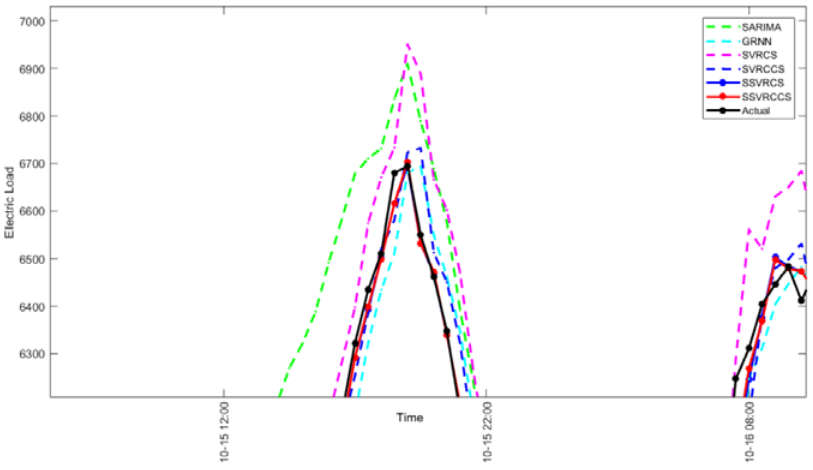
Figure 7. The enlargement comparison of Peak 3 from the compared models for Example 1.